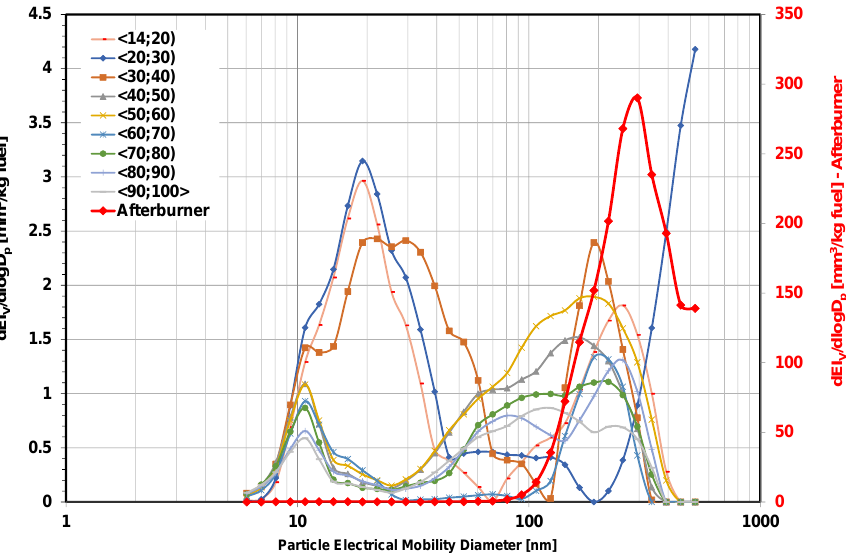
Figure 4. Differential Particle Volume Emission Index (EI V ) PSD for the entire range of engine operation and the afterburner.